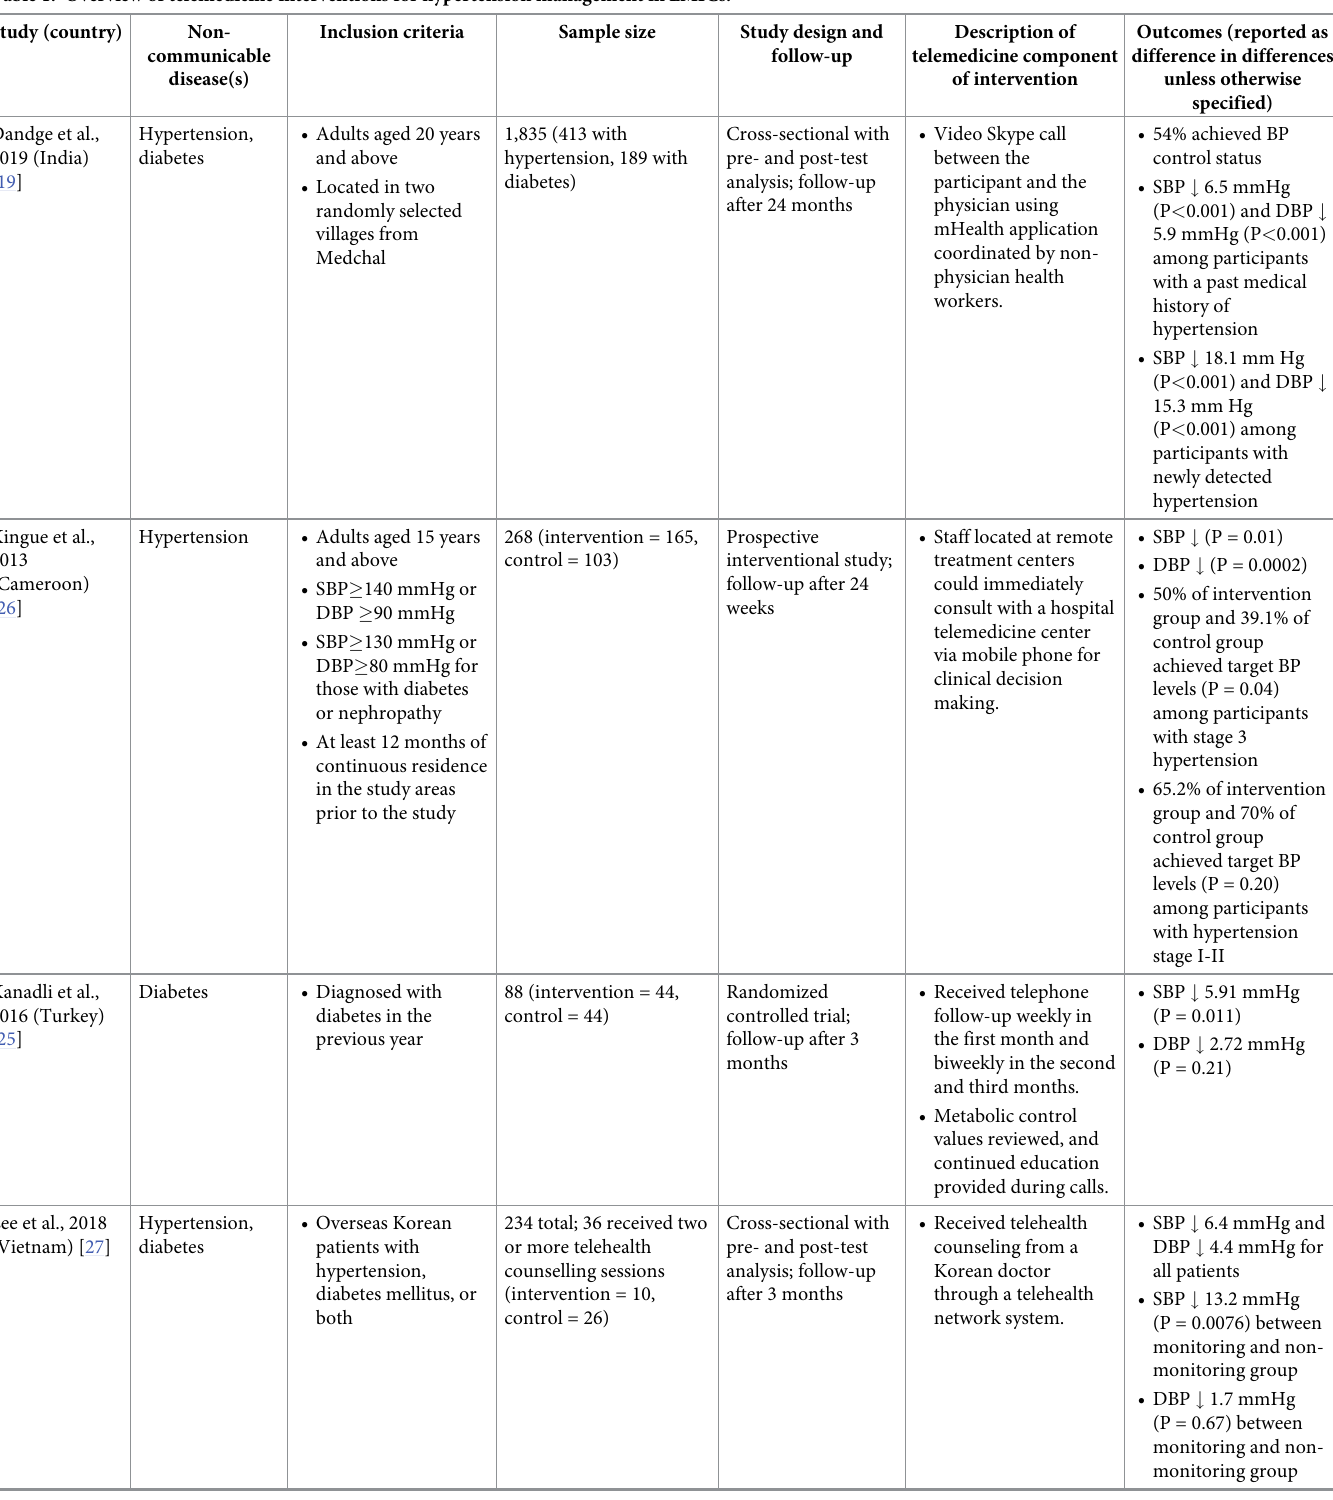
Table 1. Overview of telemedicine interventions for hypertension management in